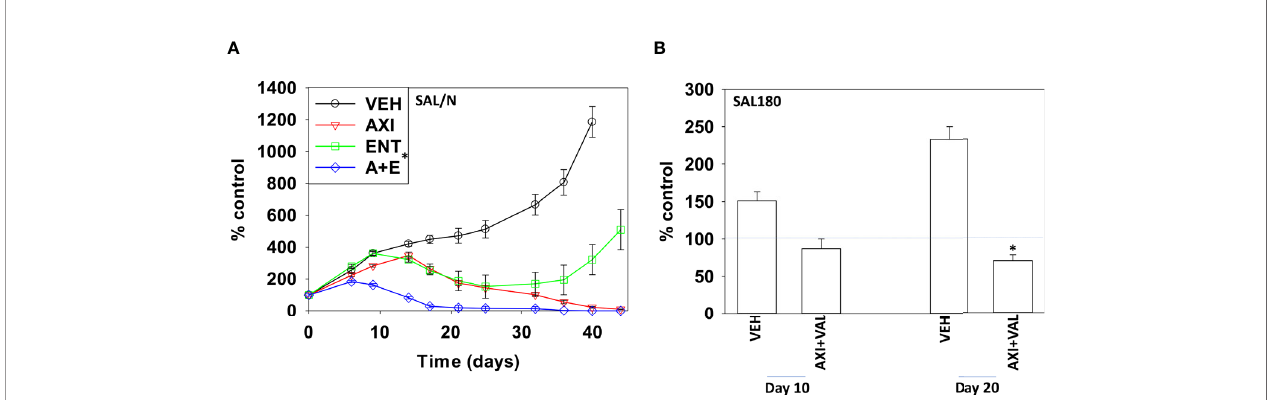
FIGURE 6 | Axitinib and HDAC inhibitors interact to suppress the growth of mouse sarcoma tumors grown in their syngeneic host. (A) SAL/N tumors were treated with vehicle control, axitinib, entinostat or the drug combination for 21 days as described in the Methods. Tumor volumes were measured for 44 days after the initiation of treatment. (n = 10 animals per group +/-SD) *p < 0.05 less than axitinib alone growth. (B) SAL180 tumors were grown to a volume of ~100 mm 3 and then treated with either vehicle control or with [axitinib + valproate] for 20 days as described in the Methods. Tumor volumes were measured (n = 8 animal per group +/-SD). *p < 0.05 less than vehicle control.